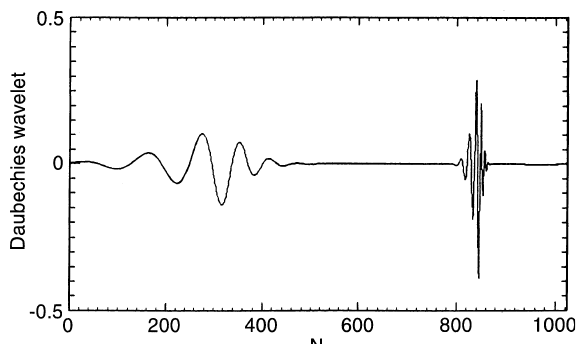
Fig. 1. Daubechies wavelets with 20 coe(cid:129)cients at two di(cid:128)erent scales and positions. The x -axis shows position and the y -axis shows the wavelet amplitude